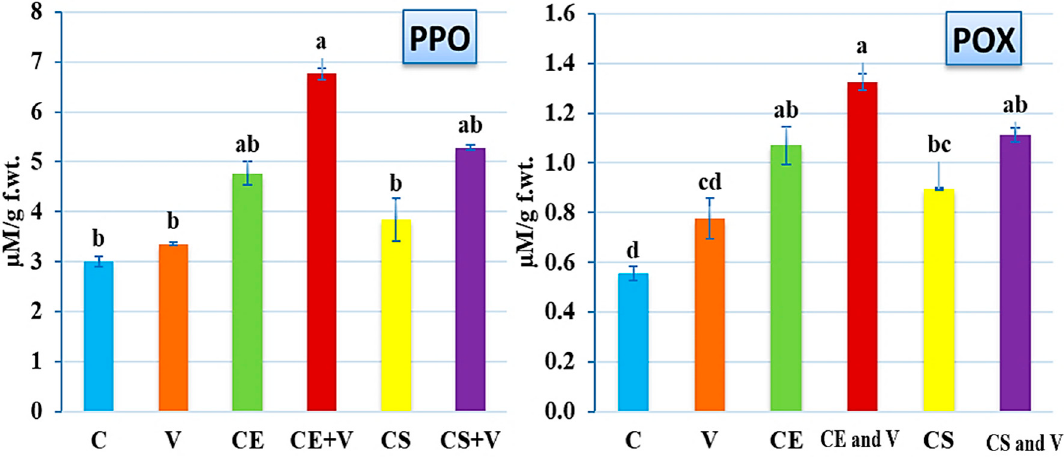
Figure 7. Effect of the foliar application of nanoclay on the PPO and POX of potato plants at 28 days after PVY inoculation. C: control potato plants; V: potato plants inoculated with PVY; CE: potato plants treated with Egyptian nanoclay; CE and V: potato plants inoculated with Egyptian nanoclay 48 h before PVY inoculation; CS: potato plants treated with standard nanoclay; CS and V: potato plants inoculated with standard nanoclay 48 h before PVY inoculation. The columns reflect the average value of five biological replicates, while the bars represent the standard deviation (SD). According to Tukey’s HSD test ( p ≤ 0.05), the values of each column following the same letter (a/b/c/d/e/f) do not significantly differ.